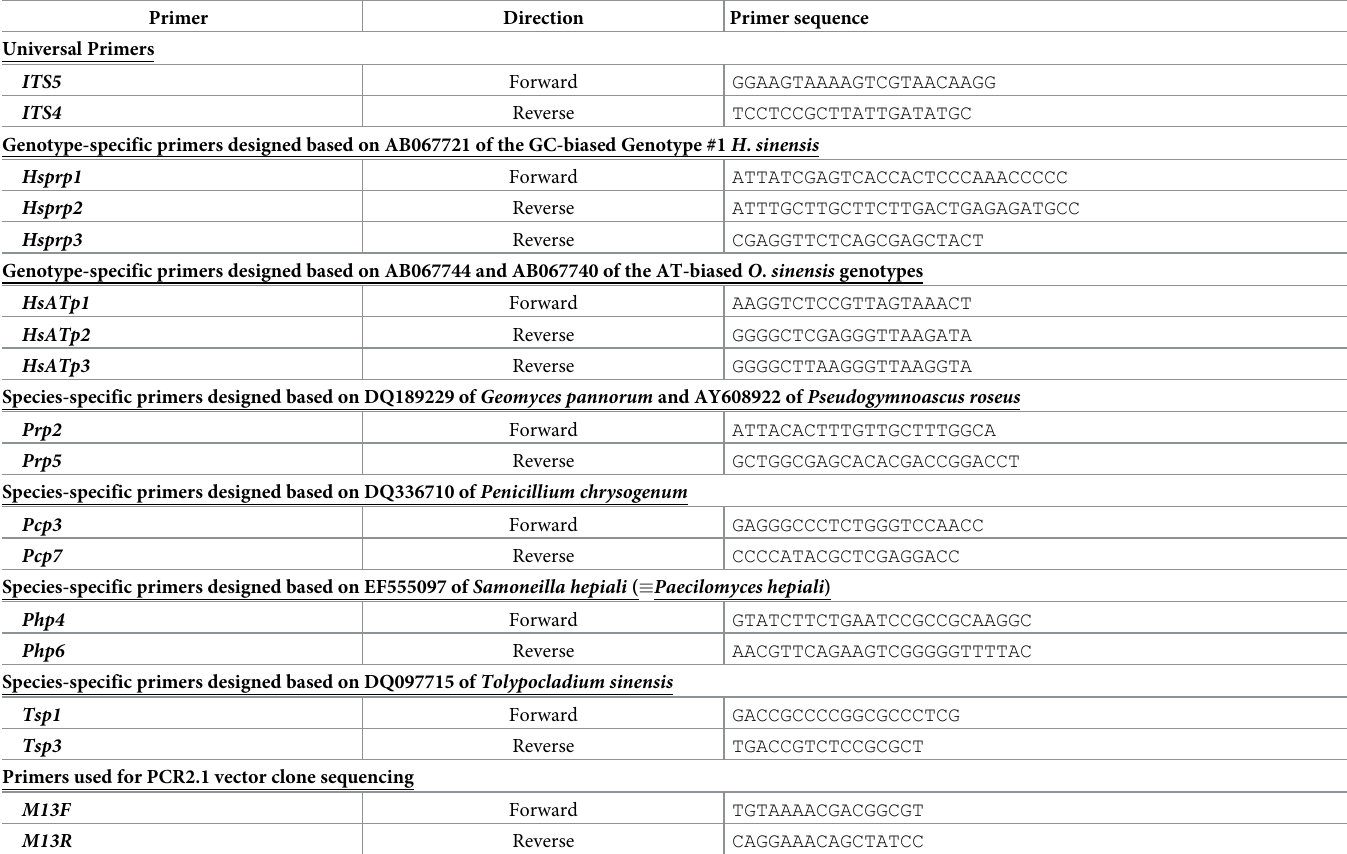
Table 1. ITS5/ITS4 universal primers and genotype- and species-specific primers used for the PCR amplification and sequencing of ITS